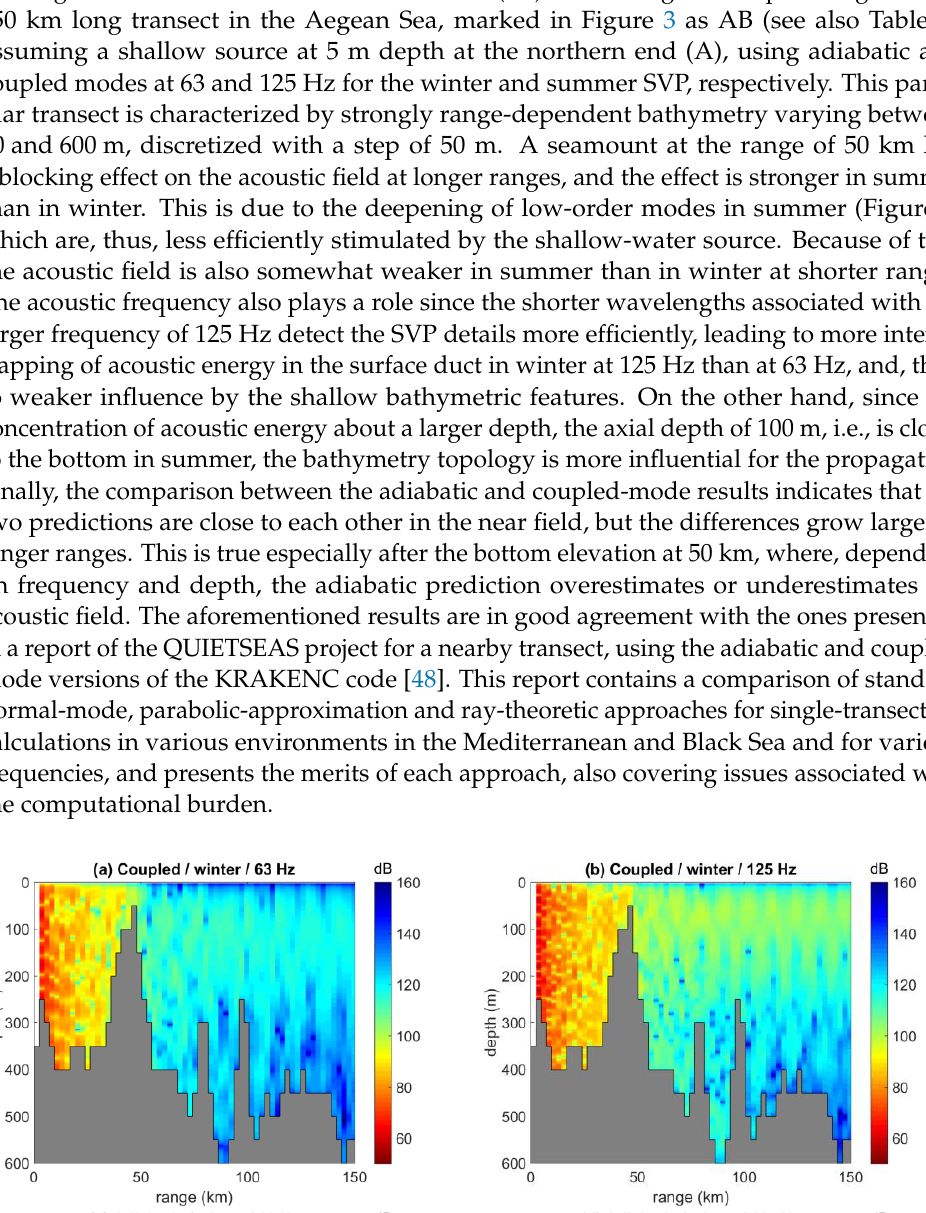
Figure 7. Transmission loss (dB) along transect AB for the summer SVP for a source depth of 5 m. ( a ) Coupled-mode results at 63 Hz; ( b ) Coupled-mode results at 125 Hz; ( c ) Adiabatic results at 63 Hz; ( d ) Adiabatic results at 125 Hz.